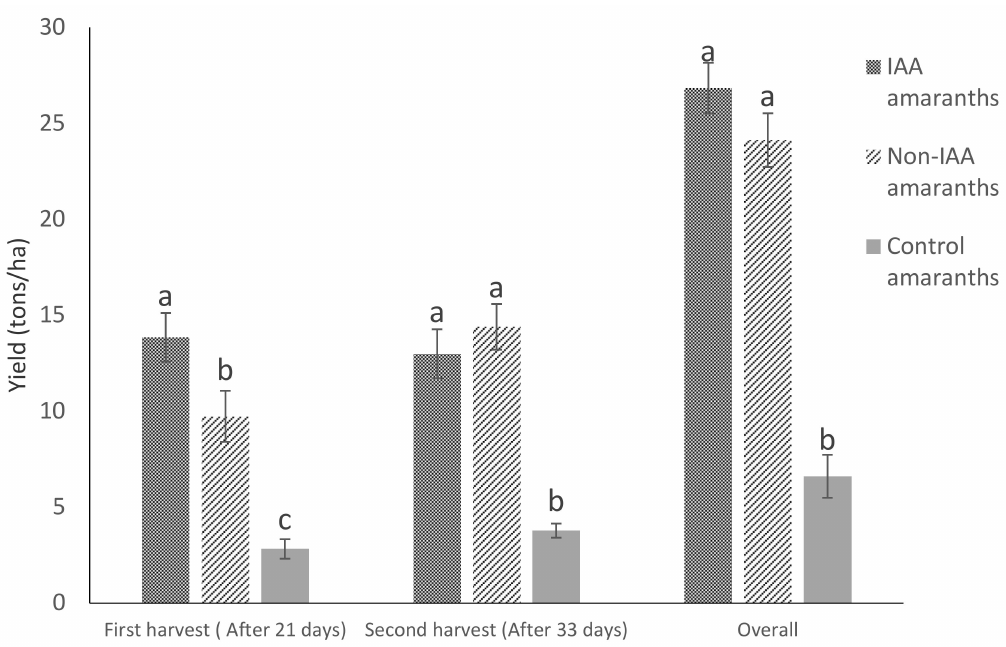
Figure 2. Amaranth yield under di ff erent farming systems and harvesting periods (bars with di ff erent letters are significantly di ff erent, p < 0.05). (Bars represent means ± SE).